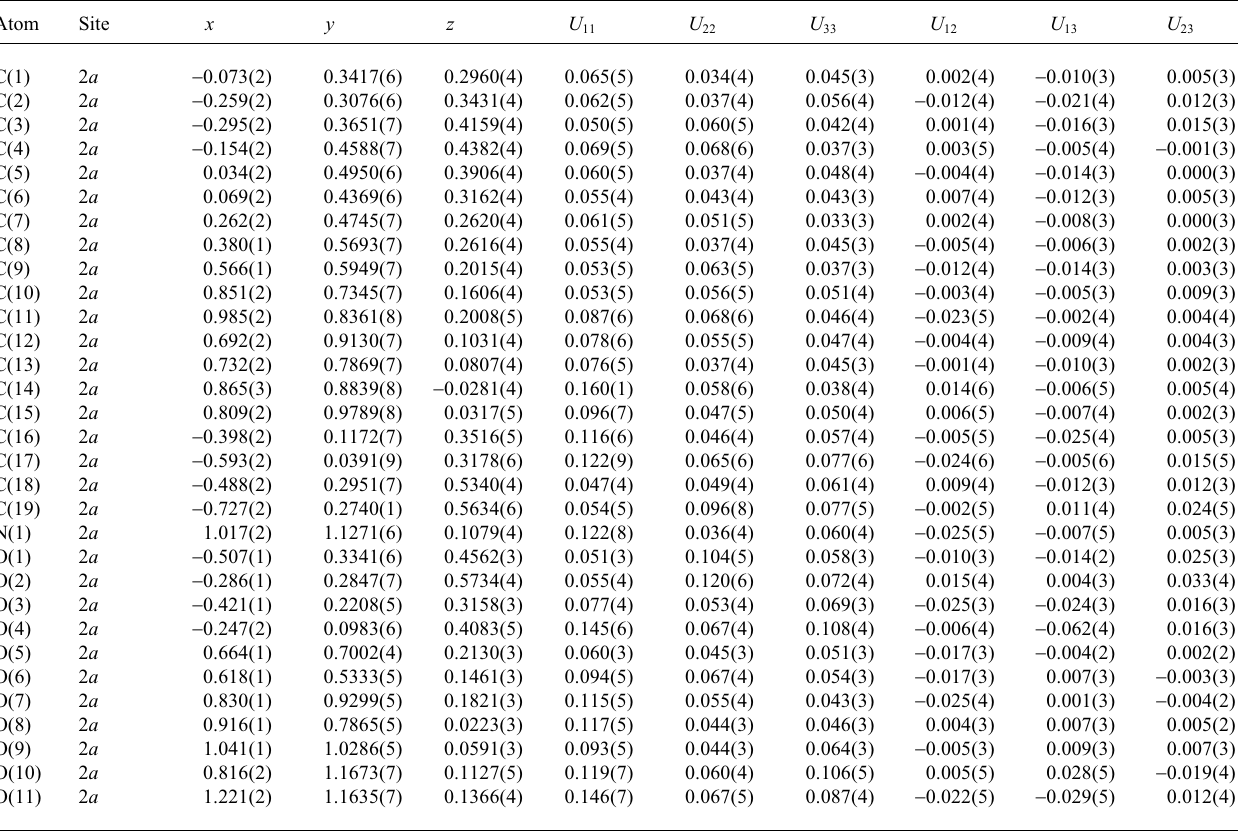
Table 3. Atomic coordinates and displacement parameters (in Å 2 )